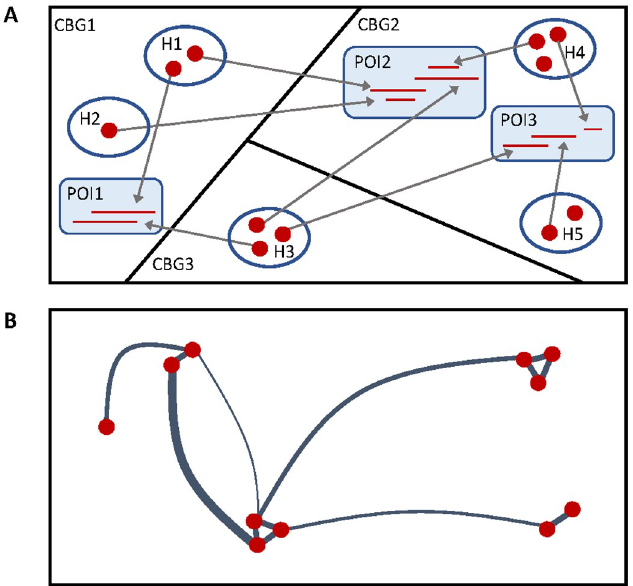
Fig 1. Diagram of contact network construction from mobility and census data. A. Mobility and census data represents people (red dots) from specific households (H) and census block groups (CBGs) visiting places of interest (POIs), B. Contact networks are generated from this data on a weekly basis. The edge weight represents the interaction strength between people.